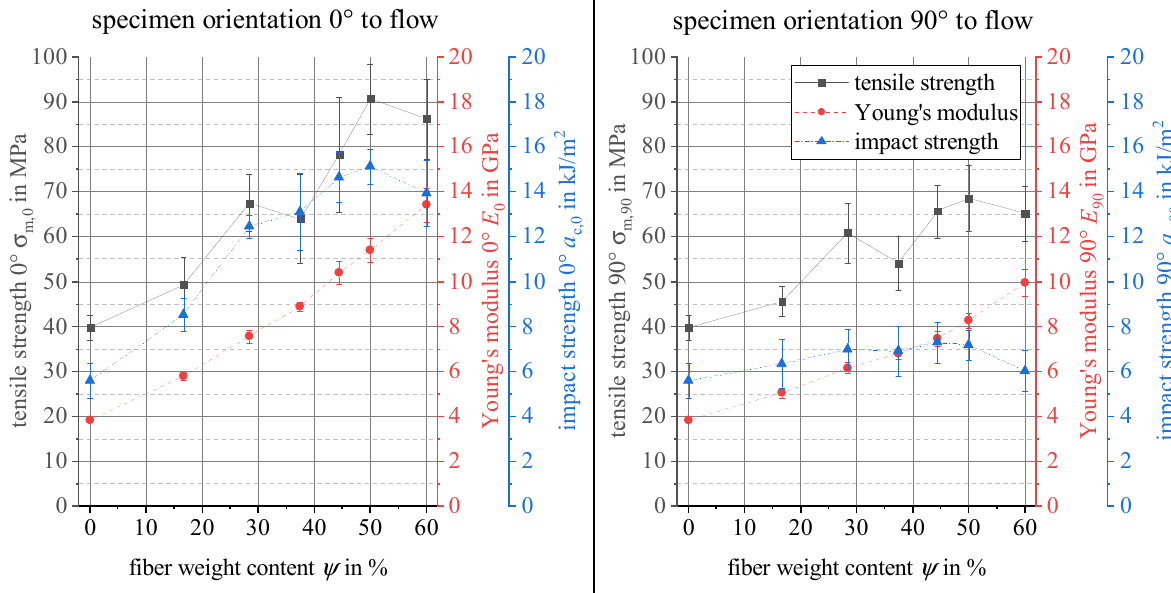
Figure 7. Results for the tensile testing and the Charpy impact testing.